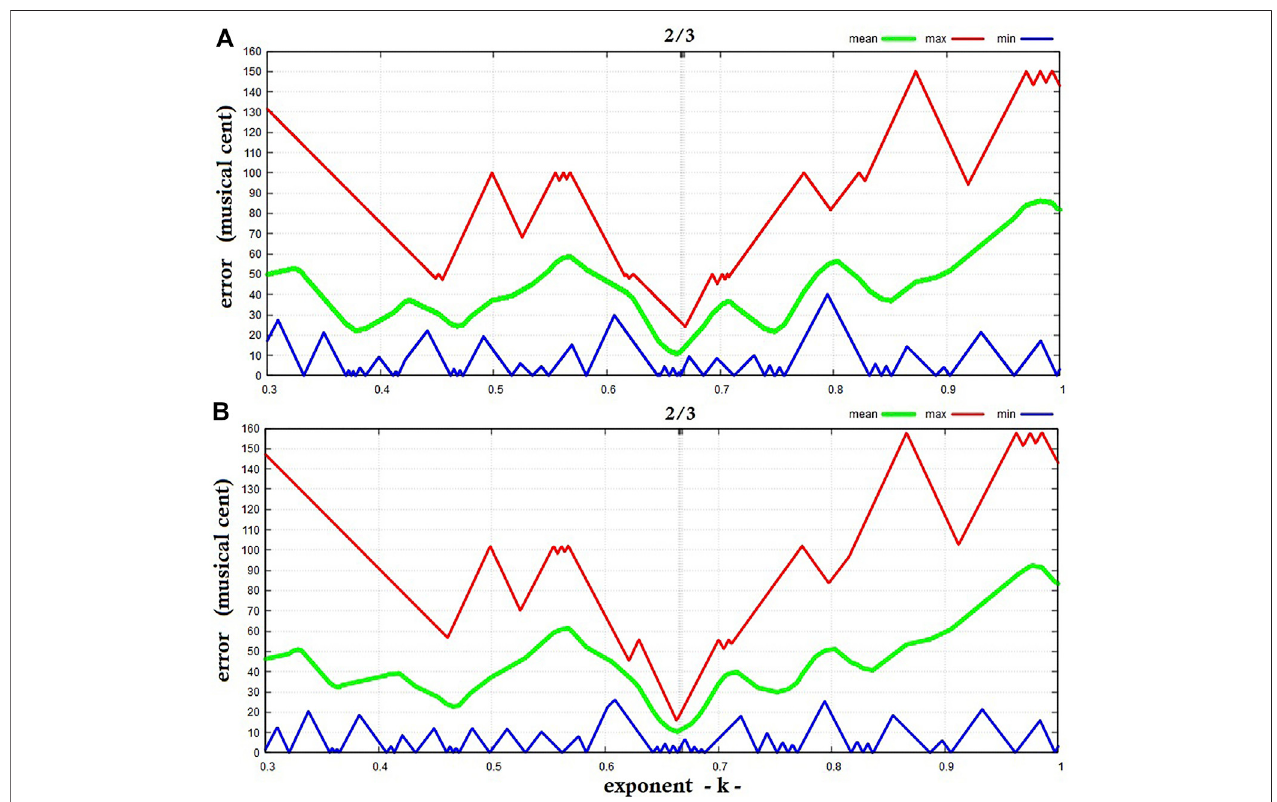
FIGURE 5 | Exponent k versus average, maximum and minimum error measured in musical cents from adjacent planet distance ratios raised to the exponent k to the closest musical consonance for: (A) 12-TET system; (B) the 12-TJI system. The value for k (cid:1) 2/3 ≈ 0.667 is highlighted.